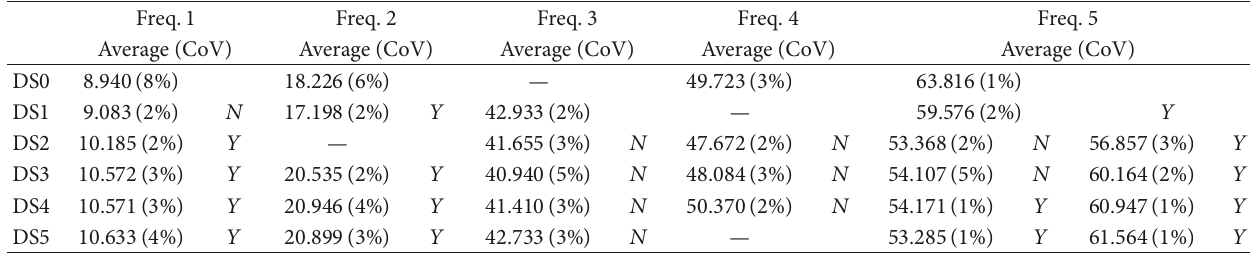
Table 4: Modal frequencies detected by applying SSI method.